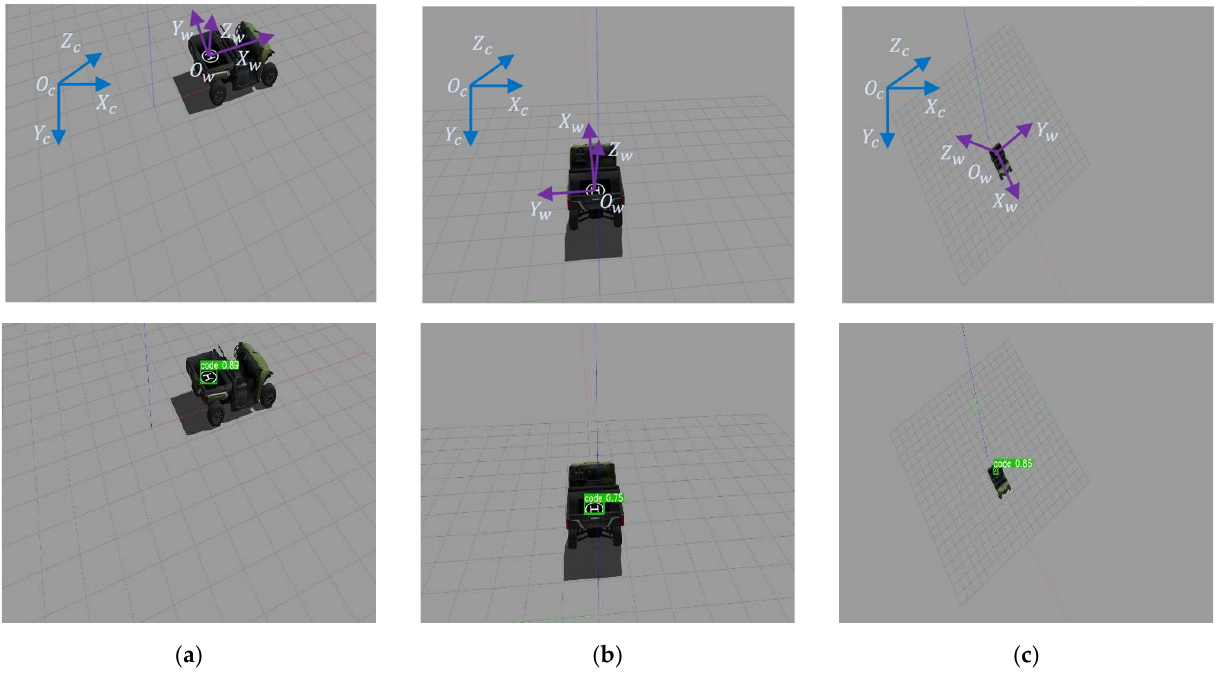
Figure 8. Examples of target images with labels: ( a ) camera tilt view; ( b ) target occlusion; and ( c ) small target. ( c ) small Table 1. Model Performance Comparison.